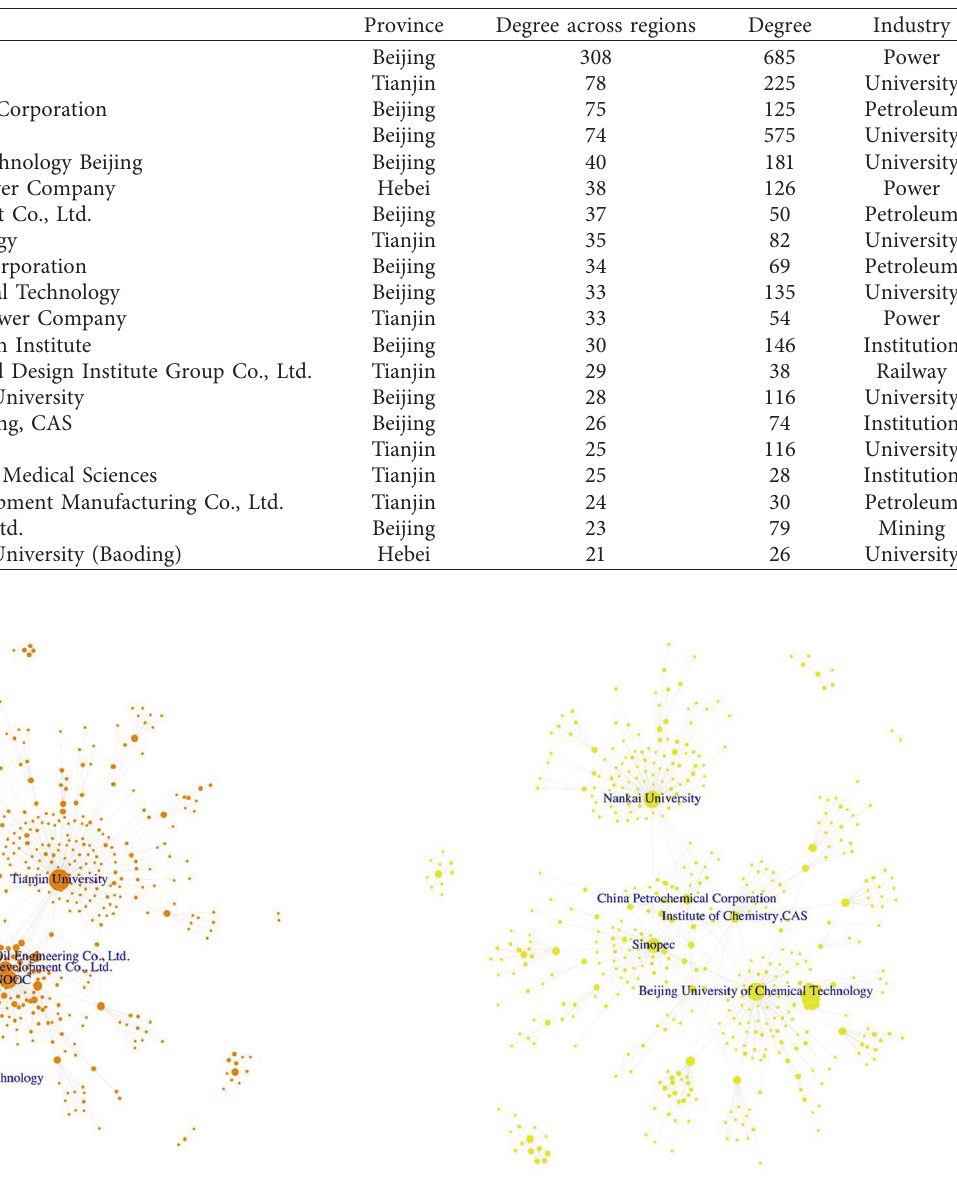
Table 8: Top 20 nodes with the largest degree across regions.